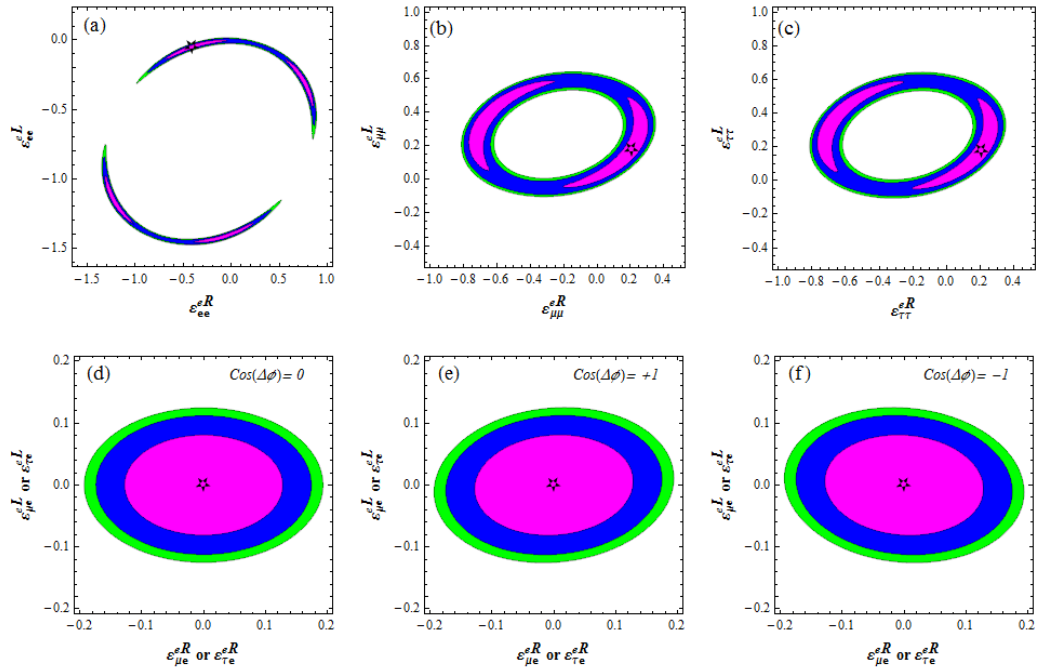
Figure 3 . Allowed 68%(magenta), 90% (blue) and 95% (green) C.L. joint parameter correlations of the NU and FC LH and RH subspaces for NSIs at the detector. The star indicates the \best-(cid:12)t" point for orientation in each panel. The \no-NSI" point is at the origin, which is also the best (cid:12)t point for panels d, e and f.